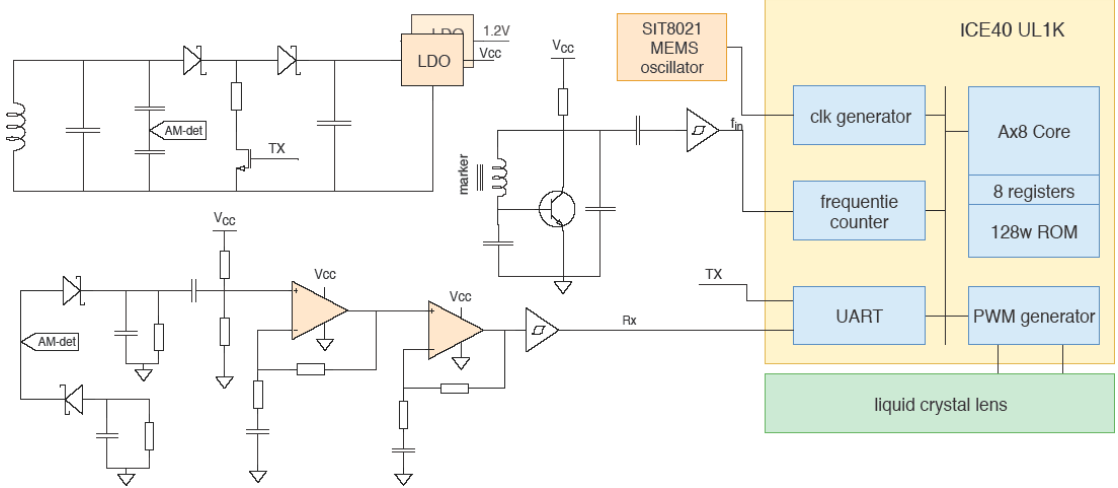
Figure 4. Block schematic of the full embedded control